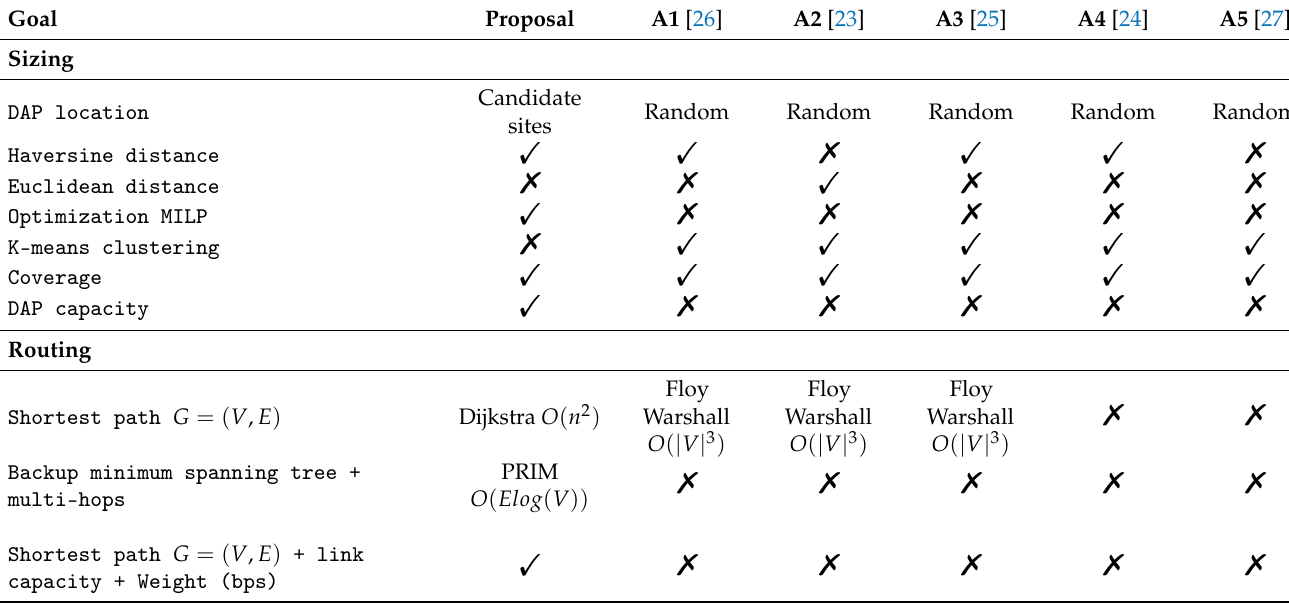
Figure 8. Coverage radius vs. total path cost. Table 4. Summary: the main contributions of similar